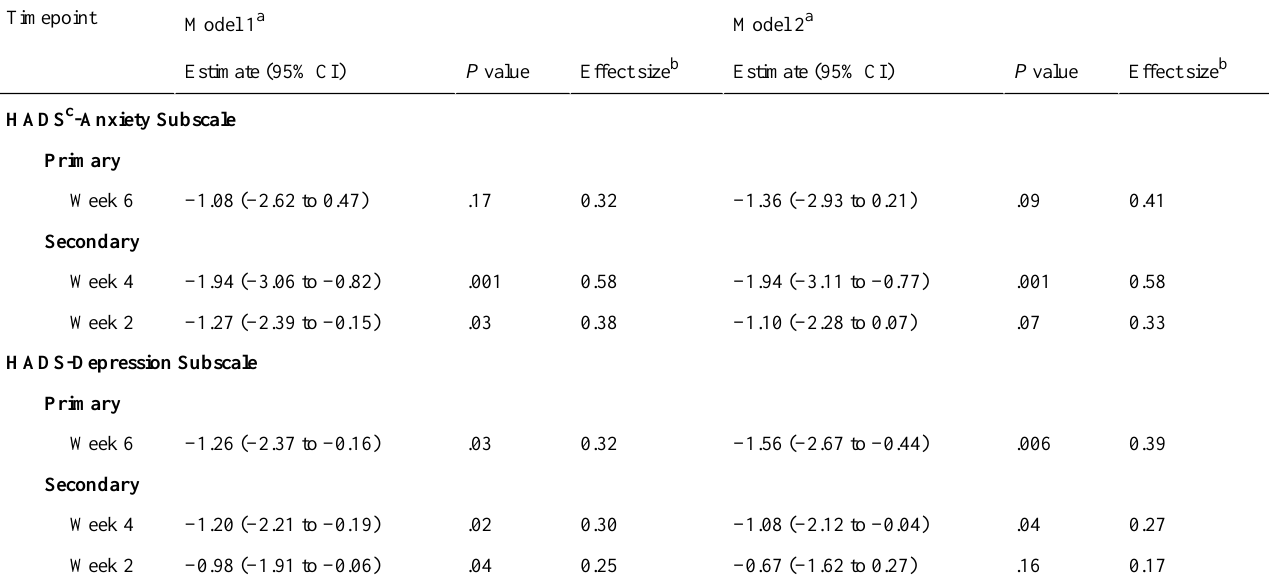
Table 3. Estimated effect of Feel Stress Free intervention on Hospital Anxiety and Depression Scale anxiety and depression scores at 2, 4, and 6 weeks of